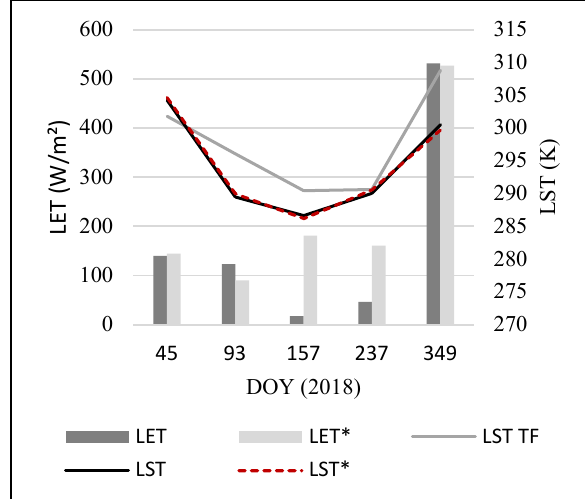
Figure 4. Land Surface Temperature (LST) and Latent Leat Flux (LET) to Native Grass at Tower Flux point, with (*) and without a noise applied to the images